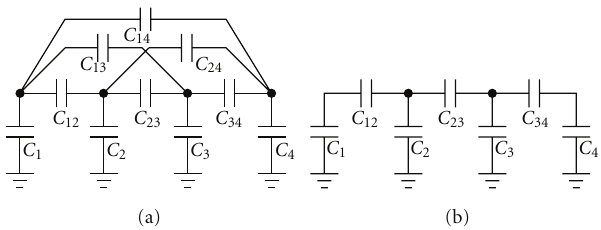
Figure 5: (a) Bus model for 4 bits. (b) The approximate bus power model.